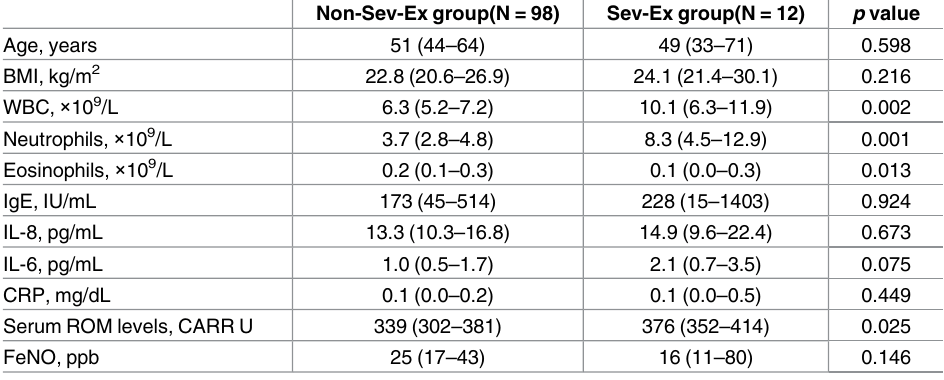
Table 5. Biomarkers and Serum ROM Levels Between Groups With and Without Severe